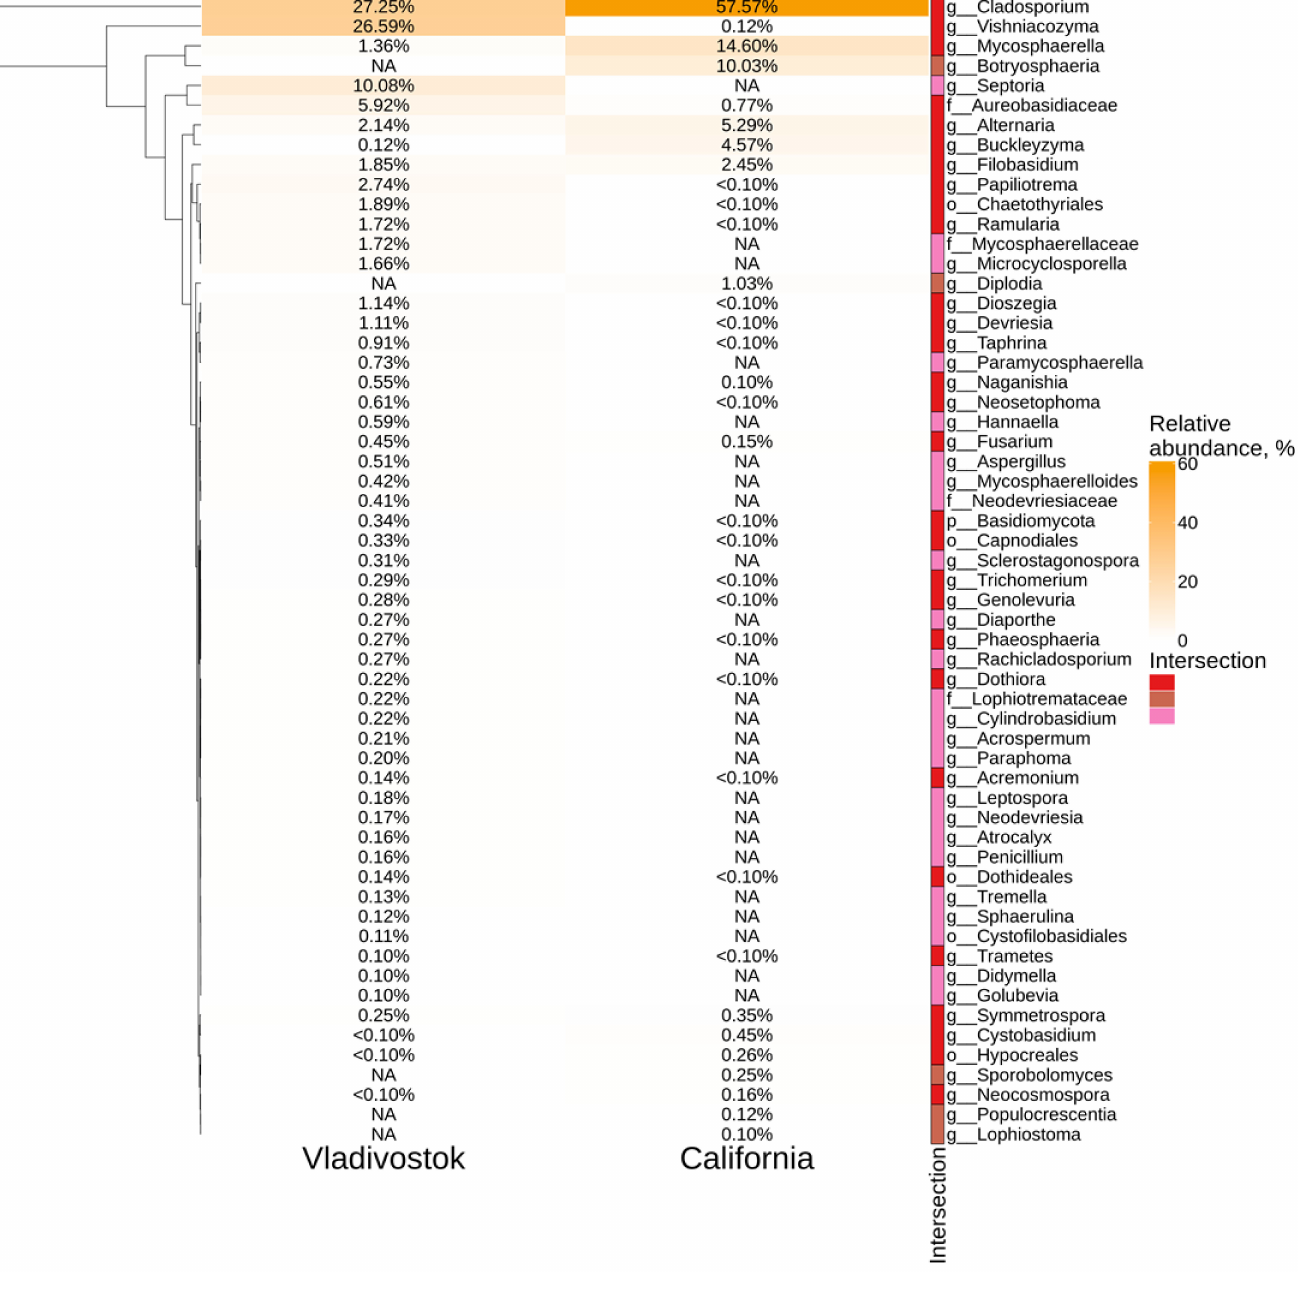
Figure 7. Genus level relative endophytic fungal abundancy heat maps of significant taxa from Vitis vinifera (USA, California) and Vitis amurensis (Russian Far East, Vladivostok). White squares (NA) represent the absence of taxa. The intersection selection was made based on the Figure